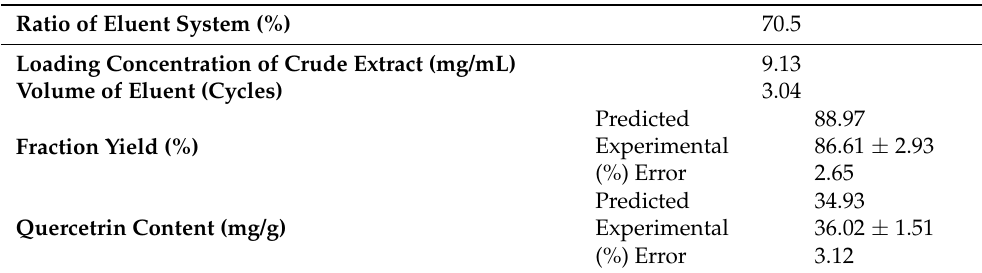
Table 3. Verification of both fraction yield and quercetrin content using the model-predicted values and experimental data at the optimized independent